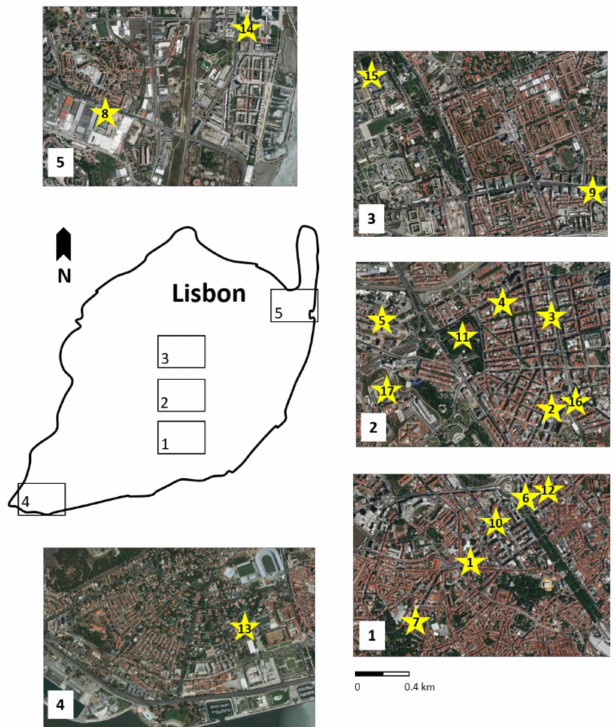
Figure 3. Location of the case studies. Areas 1, 2, and 3 are, respectively, located within the limits of Santo Ant ó nio, Avenidas Novas, and Alvalade boroughs. Case studies: